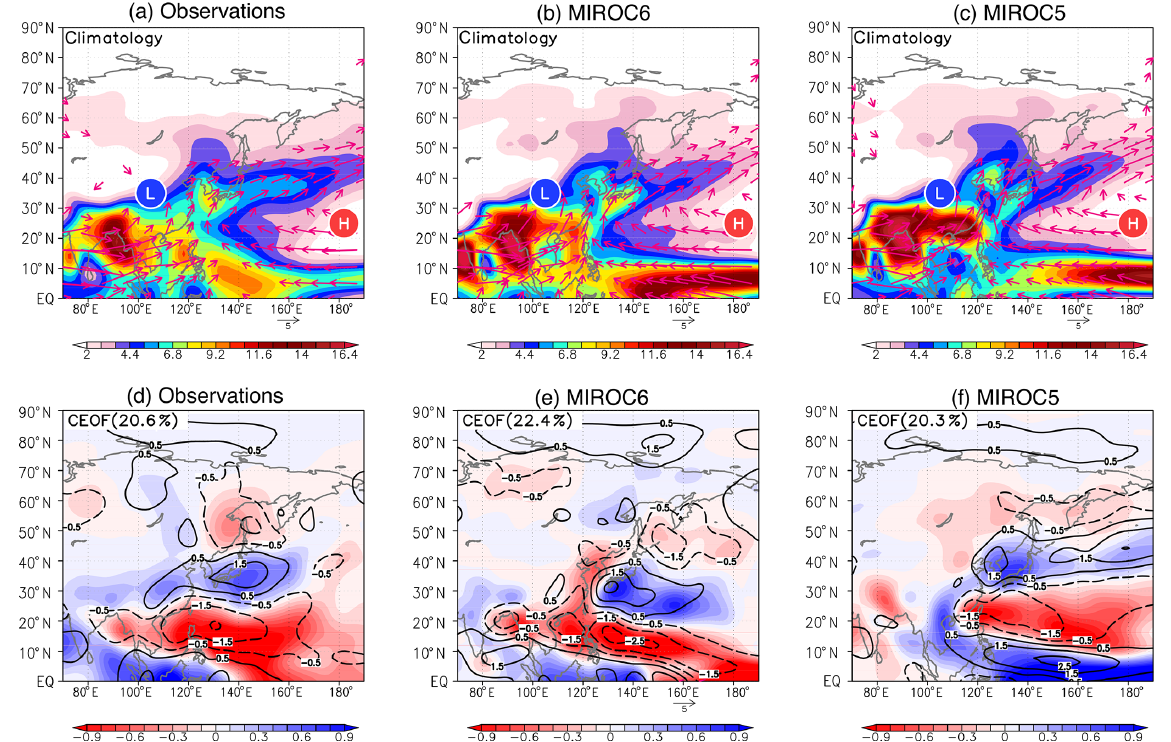
Figure 21. (a–c) Summertime (JJA) climatology of precipitation (colors; mmd − 1 ) and the 850hPa horizontal wind (vector; ms − 1 ) for (a) observations (ERA-I), (b) MIROC6, and (c) MIROC5. (d–f) Anomalies of summertime precipitation (shading; mmd − 1 ) and the 850hPa vorticity (contour; 10 − 6 s − 1 ) regressed to the time series of EOF1 of the 850hPa vorticity over [100–150 ◦ E, 0–60 ◦ N] for (d) observations, (e) MIROC6, and (f)